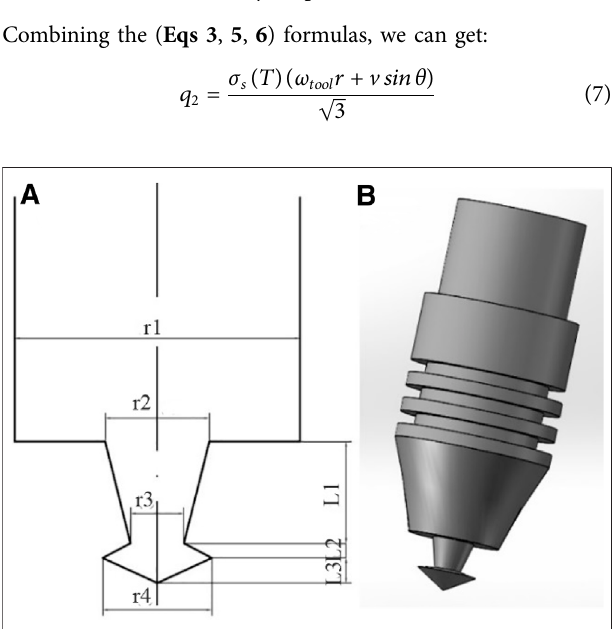
FIGURE 1 | Simpli fi ed model of SSFSW tool, (A) simpli fi ed sketch, (B) 3D